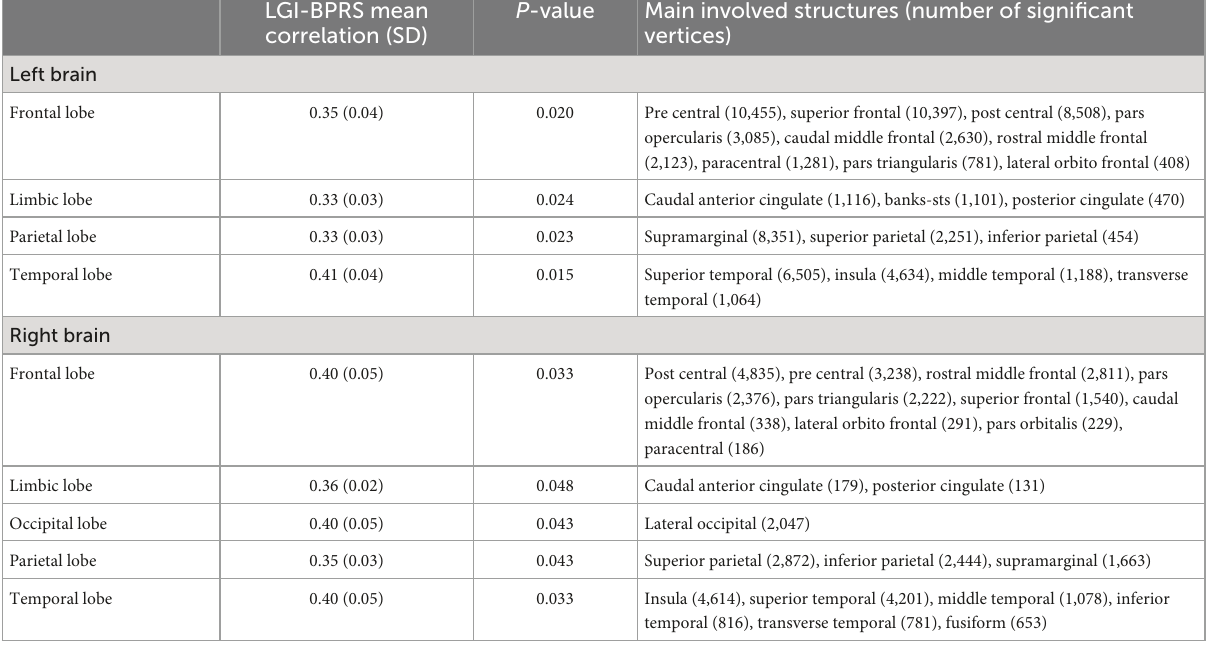
TABLE 2 LGI-BPRS correlation—whole sample.